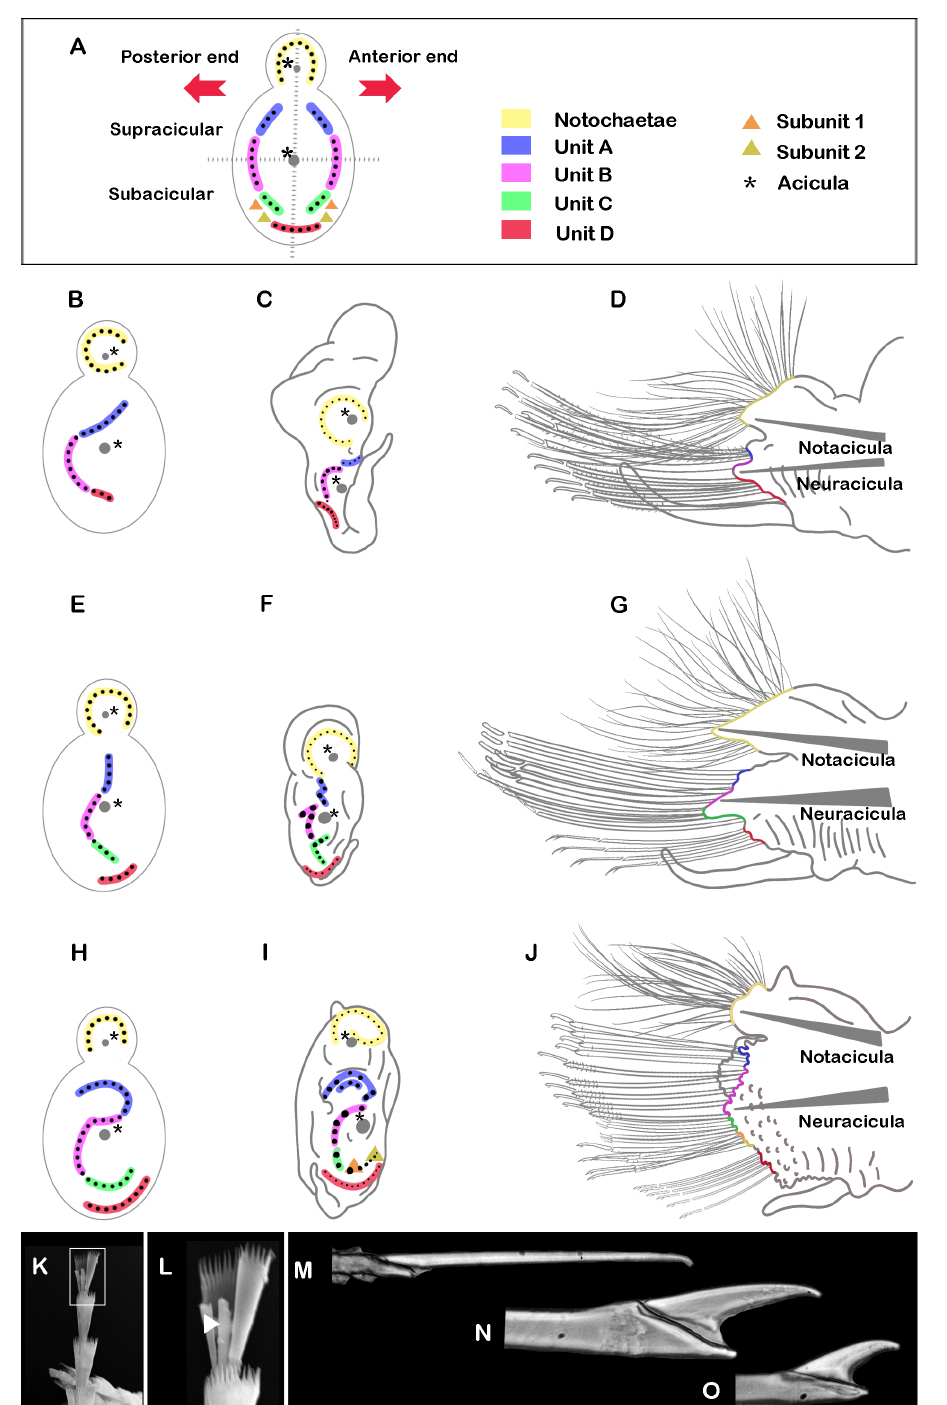
Fig. 1. Terminology of chaetal fascicles. A . Schematic parapodium of a hypothetic scaled sigalionid showing the arrangement of chaetae. B–J . Drawings from parapodia of Pelogenia sp. B–D . Segment II. B . Lateral view, scheme. C . Lateral view. D . Anterior view. E–G . Segment III. E . Lateral view, scheme. F . Lateral view. G . Anterior view. H–L . Segment form middle region. H . Lateral view, scheme. I . Lateral the chaetal axis. M–O . Neurochaetae from middle segment. M . Long blade. N . Medium-sized blade. O . Short